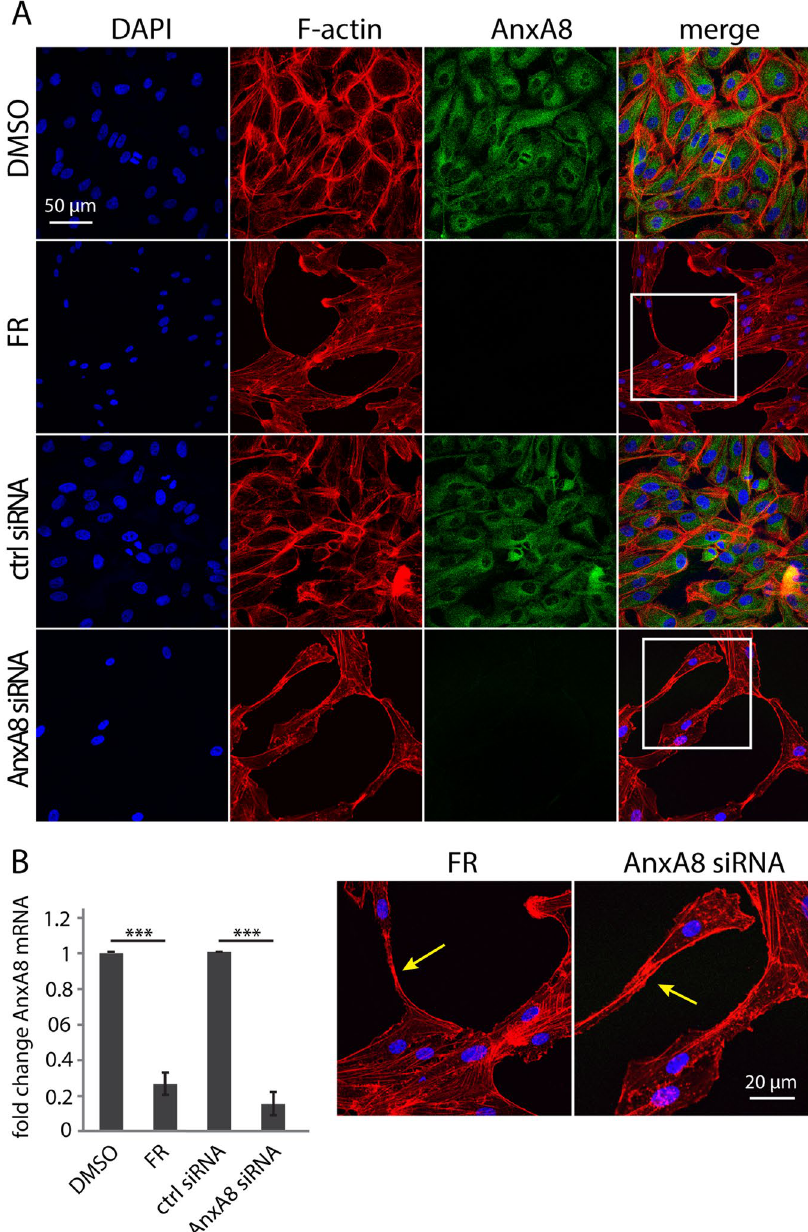
Figure 1. Suppression of AnxA8 phenocopies FR in RPE cells. ( A ) Immunofluorescence staining for AnxA8 (green) is decreased in response to both FR (7 days) and AnxA8 siRNA in ARPE-19 cells whereas vehicle (DMSO) and control siRNA had no effect. Nuclei were stained with DAPI (blue), and rhodamine phalloidin (red) revealed cell extensions in FR- or AnxA8 siRNA-treated cells (yellow arrows in insets). Experiments were performed three times and representative images are shown, scale bar = 50 µ m. ( B ) Expression levels of AnxA8 were analysed with real-time PCR. Both FR and AnxA8 siRNA elicited significant reductions in the level of AnxA8 mRNA. Shown are mean and standard error of five independent experiments. Student’s t-test was used to calculate statistical significance ( *** = P <